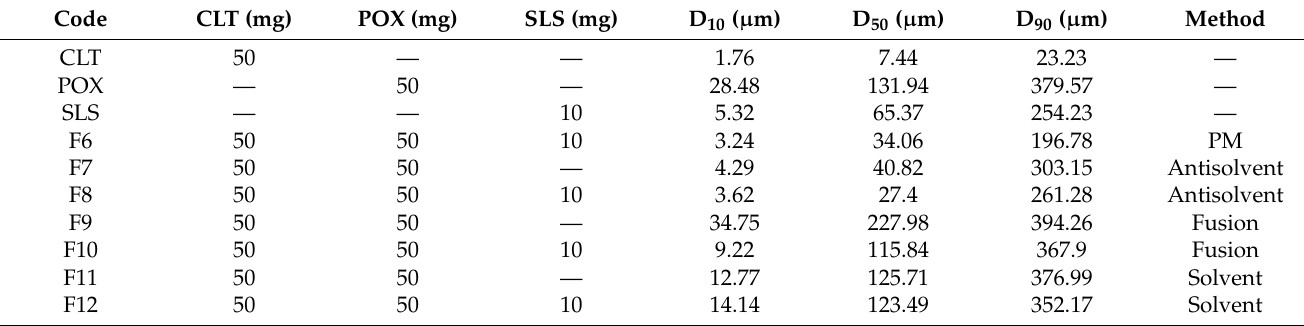
Table 3. Particle size distribution of PM and SDs according to formulation compositions and preparation methods.